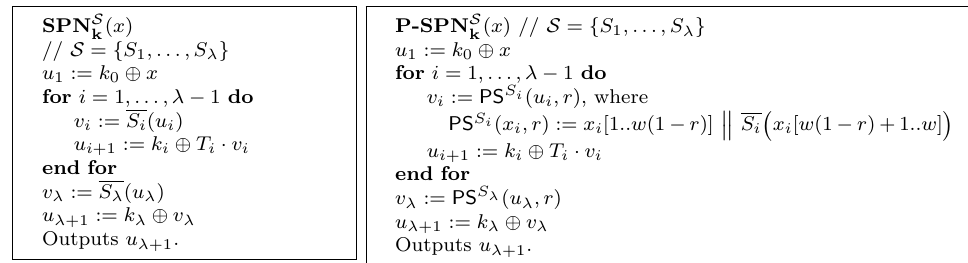
Figure 2: The computation flows in λ -round SPN and P-SPN upon input x .